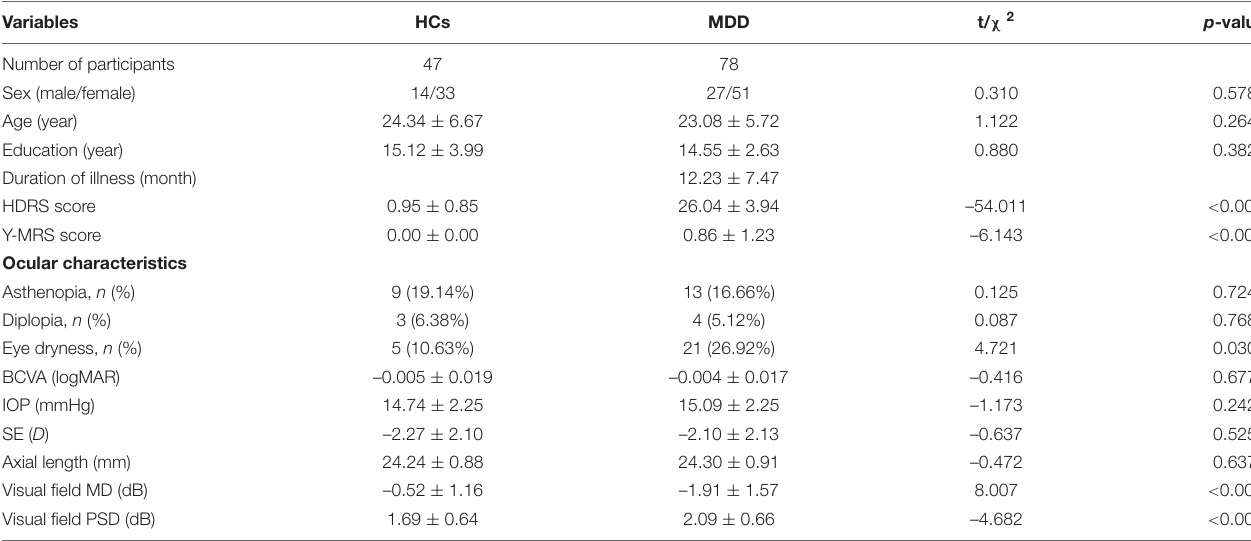
TABLE 1 | Demographic, clinical, and ocular characteristics of